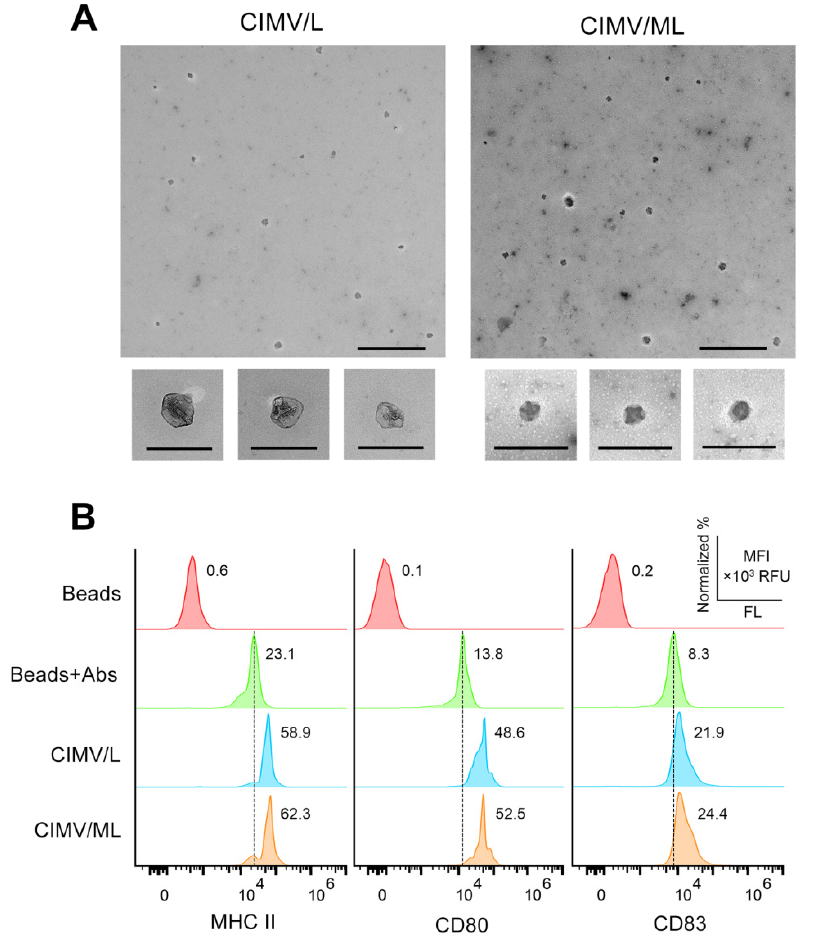
Figure 1. Characterization of tsDC-derived CIMVs. ( A ) Analysis of the morphology of CIMVs using TEM. TEM data are presented as microphotographs with scale bars = 500 nm (upper pictures) and 200 nm (bottom small pictures). ( B ) Surface expression of MHC II, CD80, and CD83 on DC-derived CIMVs. CIMVs were immobilized on aldehyde/sulfate latex beads, blocked with glycine, stained with anti-MHC II (FITC), anti-CD80 (APC), and anti-CD83 (PE) antibodies, and analyzed by flow cytometry. Data are presented as distribution of CIMVs by mean fluorescence intensity (MFI). We consider CIMVs as an alternative to natural extracellular vesicles